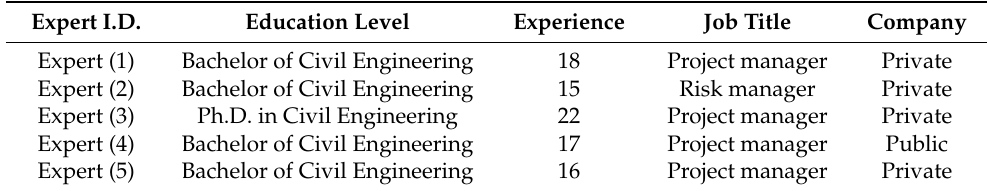
Table 3. Demographic data regarding the